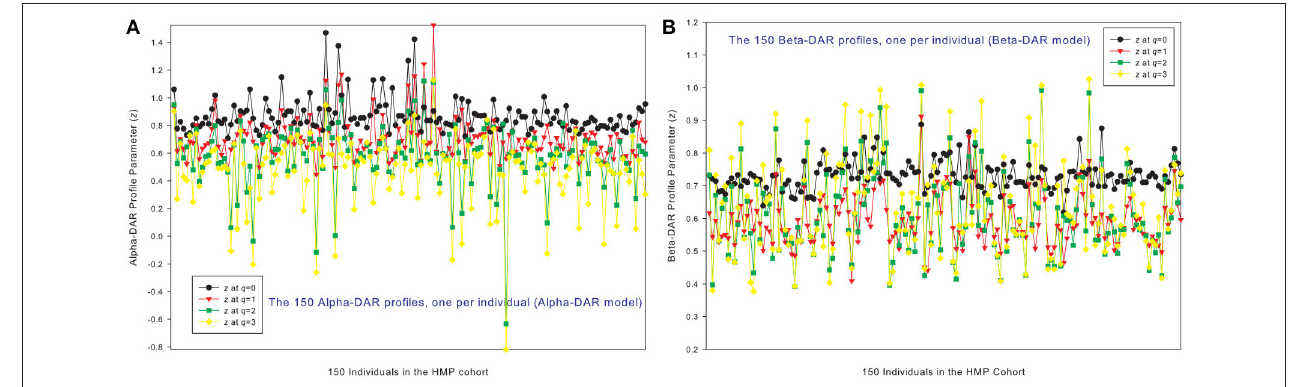
FIGURE 1 | The alpha-DAR profiles (A) and beta-DAR profiles (B) of 150 individuals in the HMP cohort: x-axis should be the subject IDs of the individuals but omitted to avoid overcrowded labeling, and y-axis is the DAR profile parameter z at four different diversity orders ( q = 0–3). Therefore, every four points corresponding to each ID on x-axis is the DAR profile of that specific individual, and the four curves constitute the DAR profiles of 150 the individuals in the HMP cohort. Inter-individual heterogeneity in the DAR profile is also obvious, which is further described with the power law statistical distribution (see Table 4 , Figure 6 ).